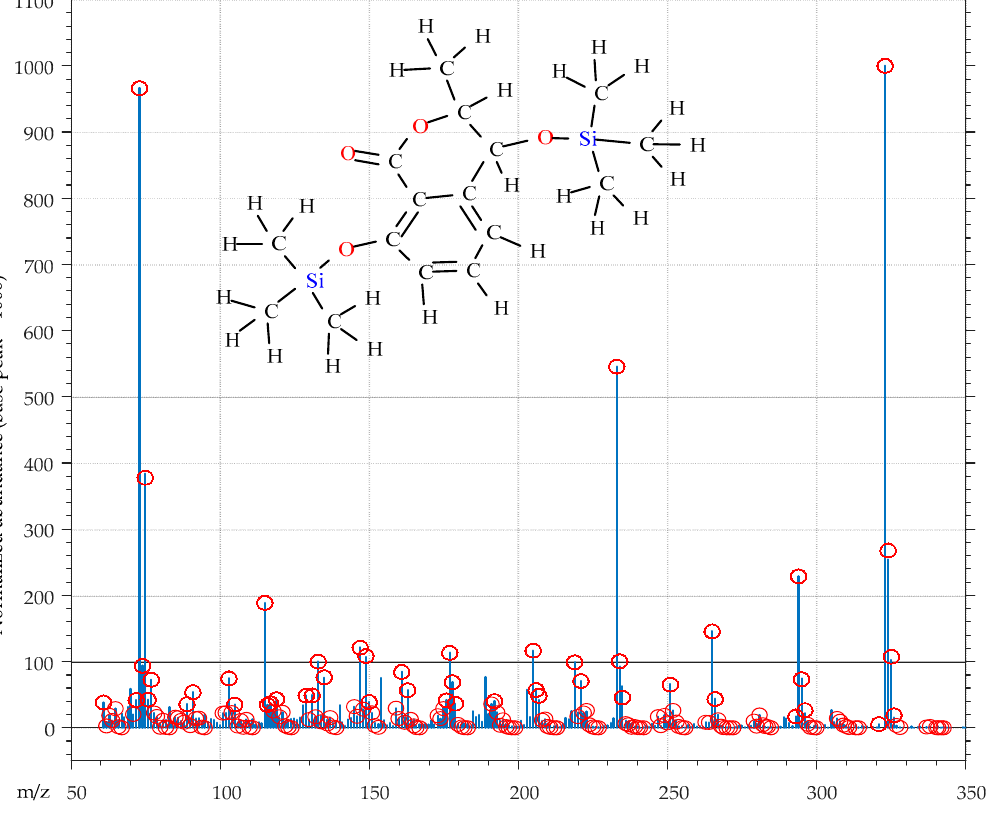
Figure 8. Ex post quality control of mass spectrum of 2TMS cis -4-hydroxymellein using the QC_Soft application. Mass peaks marked with red circles are associated to fragments created, by the software algorithm, from the hypothesized structure.